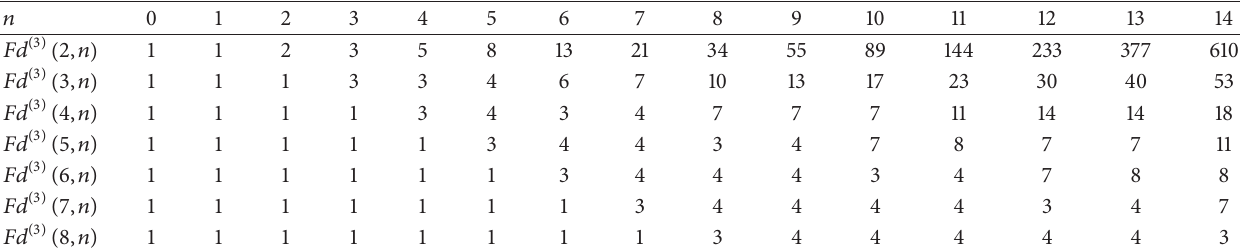
Table 3: The 𝑛 th distance Fibonacci numbers 𝐹𝑑 (3) (𝑘,𝑛) .